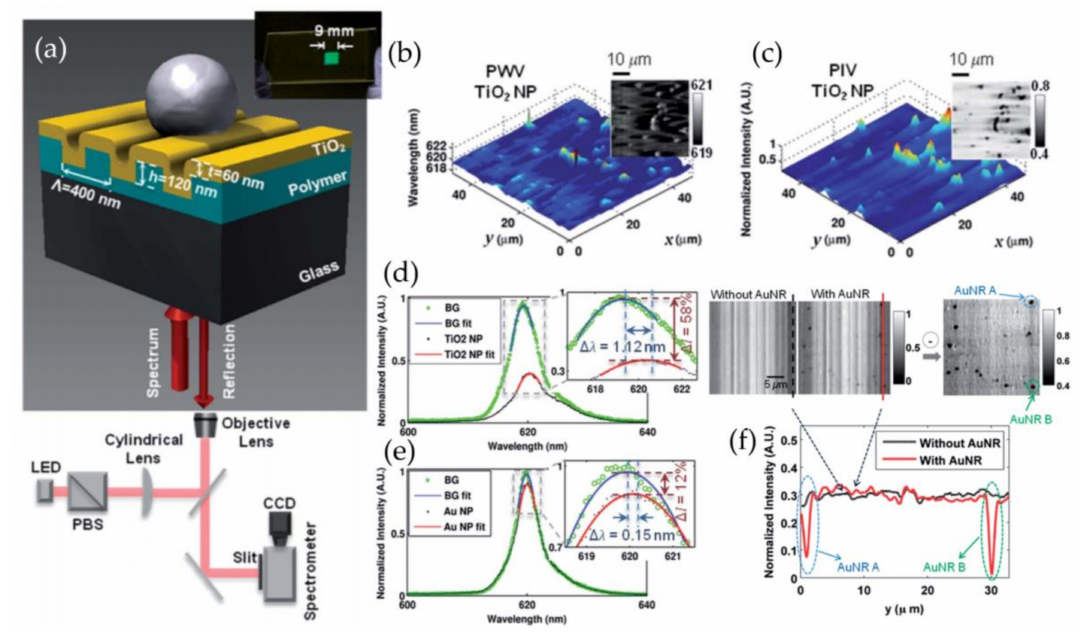
Figure 7. Photonic Crystal Enhanced Microscopy. ( a ) Schematic diagram of a nanoparticle attached to a PC surface. Inset: photo of a PC fabricated on a glass cover slip. ( b , c ) Photonic Crystal Enhanced Microscope (PCEM) detection of randomly distributed TiO 2 nanoparticles showing peak wavelength value (PWV) and peak intensity value (PIV) shift images, with representative spectra shown in ( d ). ( e ) Representative spectra of an Au nanoparticle showing PWV and PIV shifts. ( f ) PIV images of Au nanoparticles randomly distributed with a profile view of a single line scan showing clear spatially resolved PIV dips of two